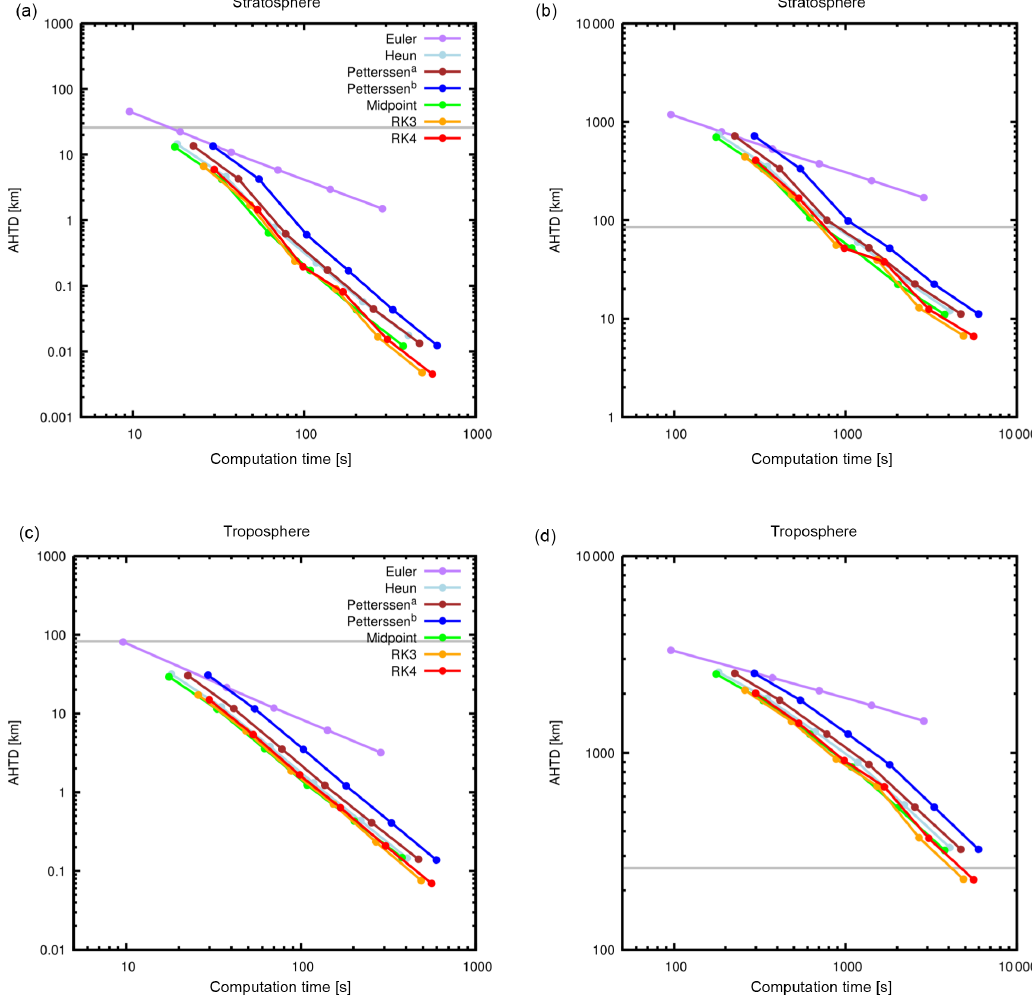
Figure 8. Trade-off between computational accuracy and total CPU-time requirements of the trajectory calculations after 24h (a, c) and 10 days (b, d) . Colored curves refer to different integration schemes. Dots along the curves indicate time steps of 3600, 1800, 900, 480, 240, and 120s (from left to right). Horizontal lines refer to the maximum tolerable error limits as defined in Sect. 2.5. The Petterssen a scheme always uses two inner iterations, which is one more than for Heun’s method. The Petterssen b scheme uses up to seven iterations with strict convergence